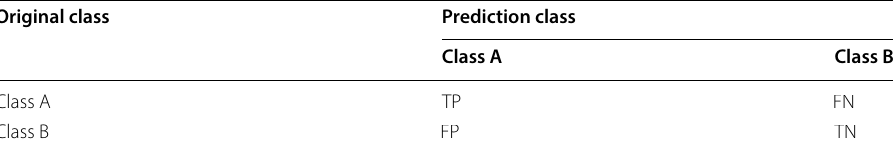
Table 2 Confusion